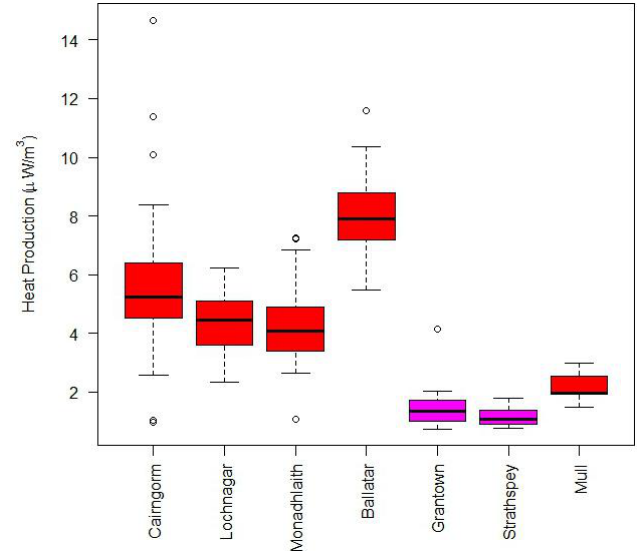
Figure 10. Box plot showing measured heat production from Scottish granite plutons. The horizontal center line in each box shows the median heat production from each pluton, the edges of the boxes are the first and third quartiles, i.e ., 50% of the data lies within the box. The whiskers extending beyond the boxes contain data which are within 1.5 times the interquartile range, and data out with this range are plotted as hoops. There are 37 readings from the Cairngorm Pluton, 34 from the Lochnagar Pluton, 22 from the Monadhliath Pluton, 19 from the Ballatar Pluton, seven from the Grantown Pluton, five from the Strathspey Pluton, and seven from the Ross of Mull